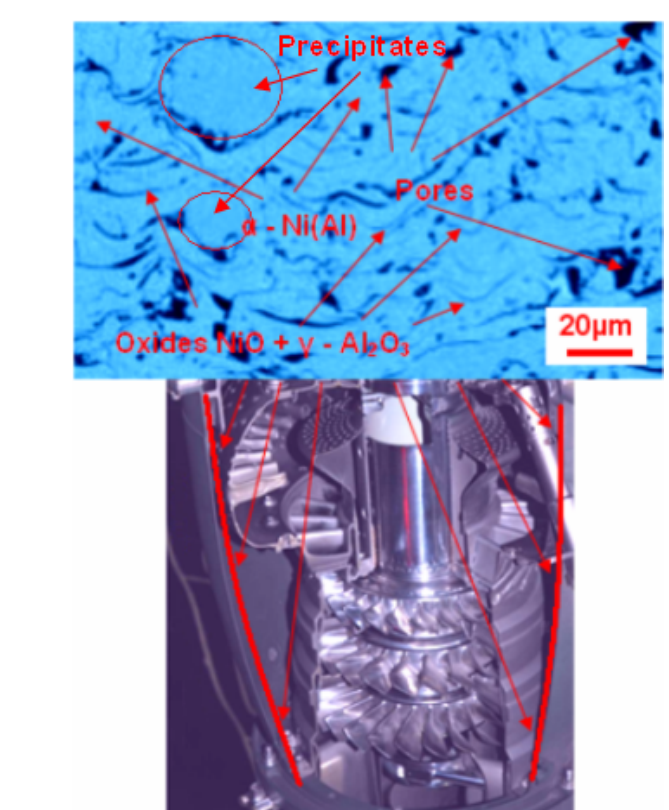
Figure 2 – Turbine casing of the ASTAZOU III B turbojet engine and the microstructure of the Ni5Al coating Рис . 2 – Корпус турбины турбореактивного двигателя ASTAZOU III B и микроструктура покрытия Ni5Al